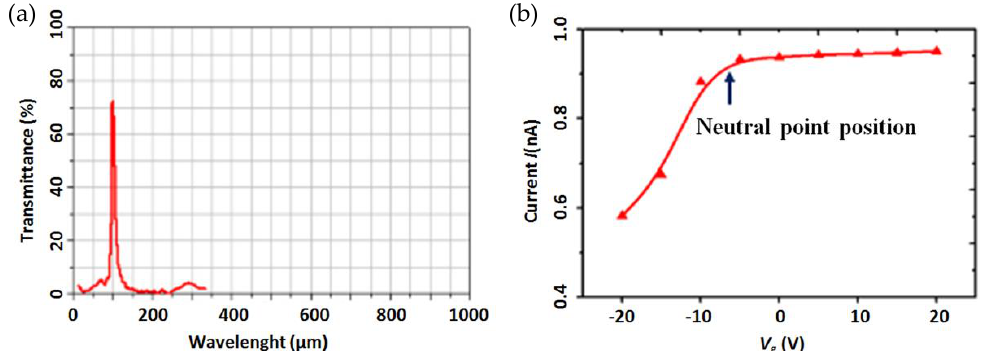
Figure 14. ( a )The terahertz transmission of BPF3.0 ( b ) the curves of the photocurrent of the FET terahertz detector versus the gate voltage.